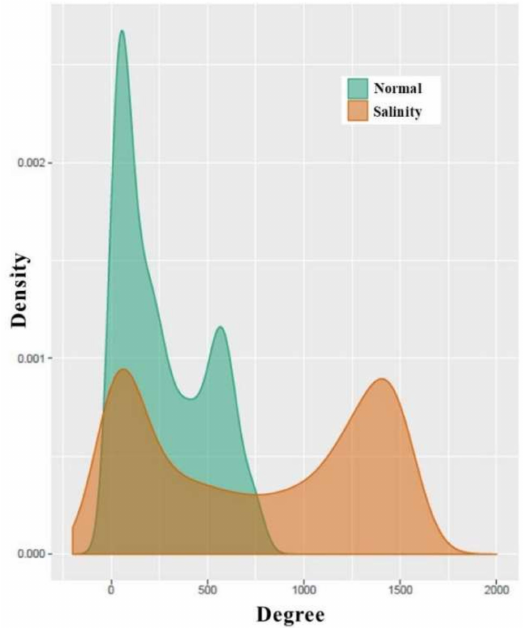
Figure 5. Degree distributions of normal-state and salinity-state networks.